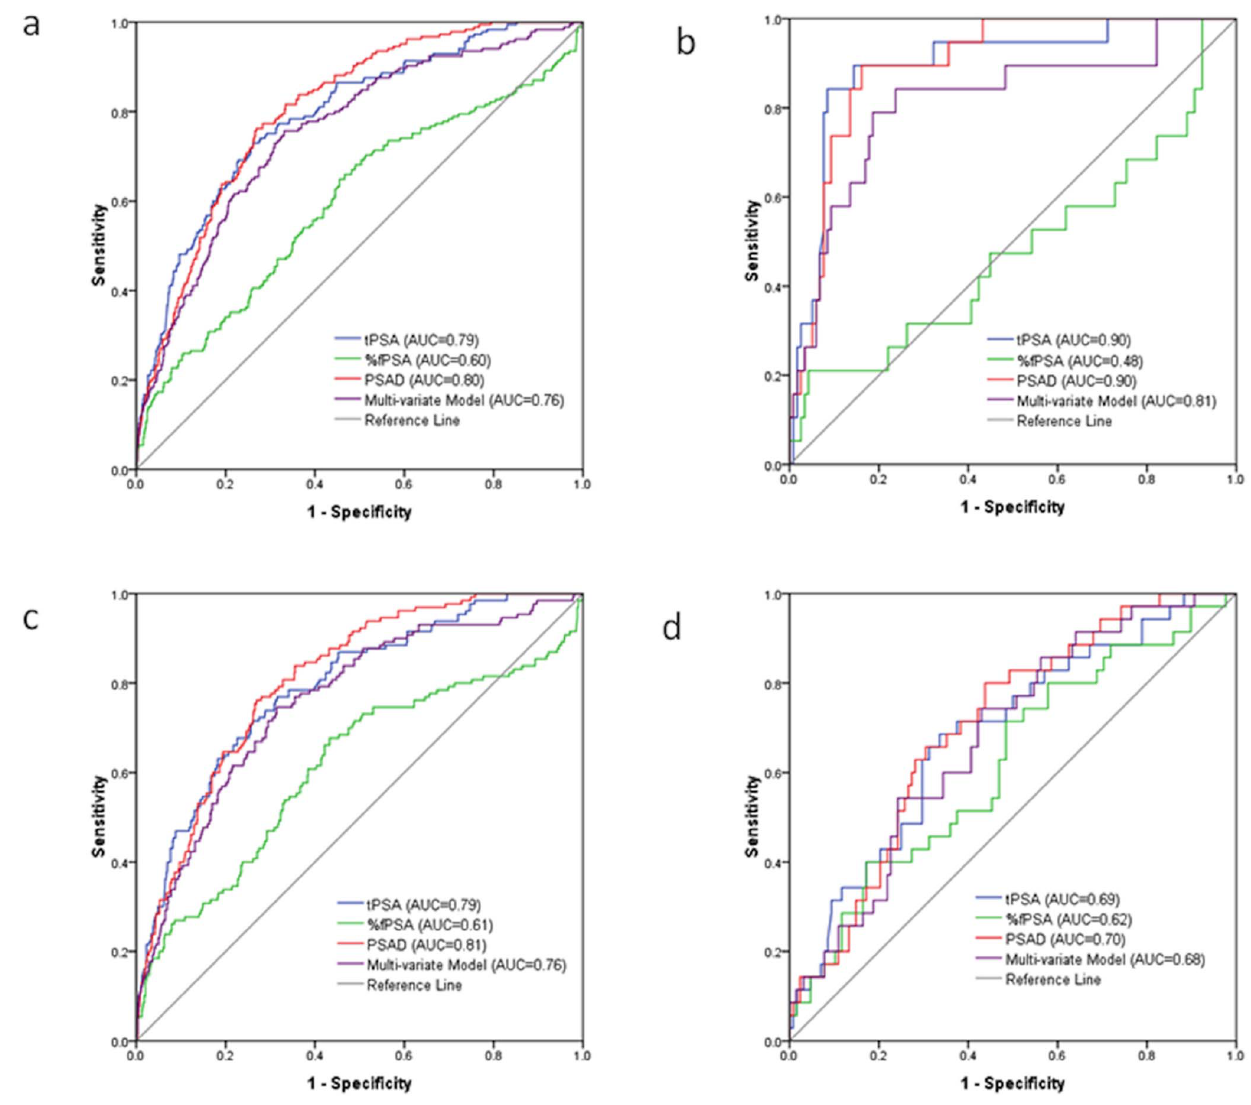
Figure 6. ROC of tPSA, %fPSA and PSAD for predicting the result of prostate biopsy for Gleason Score $ 8 PCa vs. Gleason Score , 8 and non-PCA in different age groups. (a)All study population: AUC-tPSA vs. AUC-%fPSA (P , 0.001), AUC-PSAD vs. AUC-tPSA(P . 0.05), AUC-model vs. AUC-tPSA(P . 0.05); (b) Age # 60 yr, AUC-tPSA vs. AUC-%fPSA (P , 0.001), AUC-PSAD vs. AUC-tPSA(P . 0.05), AUC-model vs. AUC-tPSA(P , 0.001); (c) Age 61–80 yr, AUC-tPSA vs. AUC-%fPSA (P , 0.001), AUC-PSAD vs. AUC-tPSA(P . 0.05), AUC-model vs. AUC-tPSA(P . 0.05); (d) Age $ 81 yr, AUC-tPSA vs. AUC-%fPSA (P . 0.05), AUC-PSAD vs. AUC-tPSA(P . 0.05), AUC-model vs. AUC-tPSA(P . 0.05).